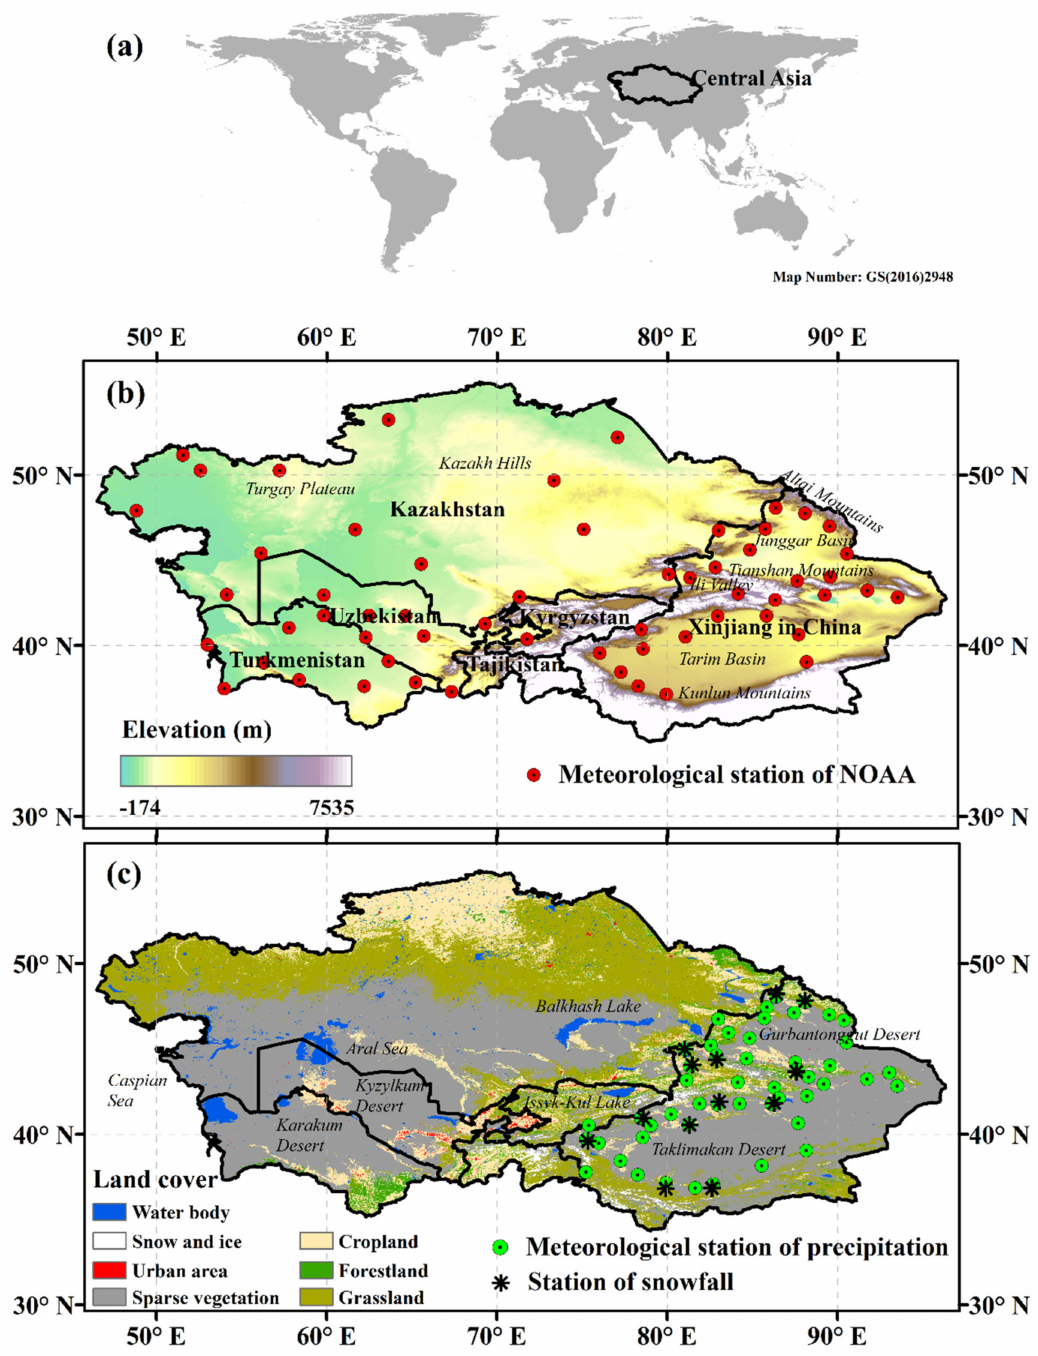
Figure 1. Geographical location in the world ( a ), elevation ( b ), and land cover ( c ) of Central Asia. Before the regional monthly precipitation, temperature, and snowfall data were used to investigate the effect of climatic factors on vegetation, the accuracy of these data was eval- uated using the observed data of stations with the area-weighted averaging method [51]. For this station-level comparison, values from grid boxes with centers within 8 km of the station were averaged. Considering the continuity of in-situ observations, the observed temperatures of 58 stations in CA (Figure 1b) were used (from the National Climatic Data Center (NCDC) of the U.S. National Oceanic and Atmospheric Administration (NOAA), ftp://ftp.ncdc.noaa.gov/pub/data/gsod/ (accessed on 20 August 2021)), as well as the observed precipitation of 50 stations (from China Meteorological Data Sharing